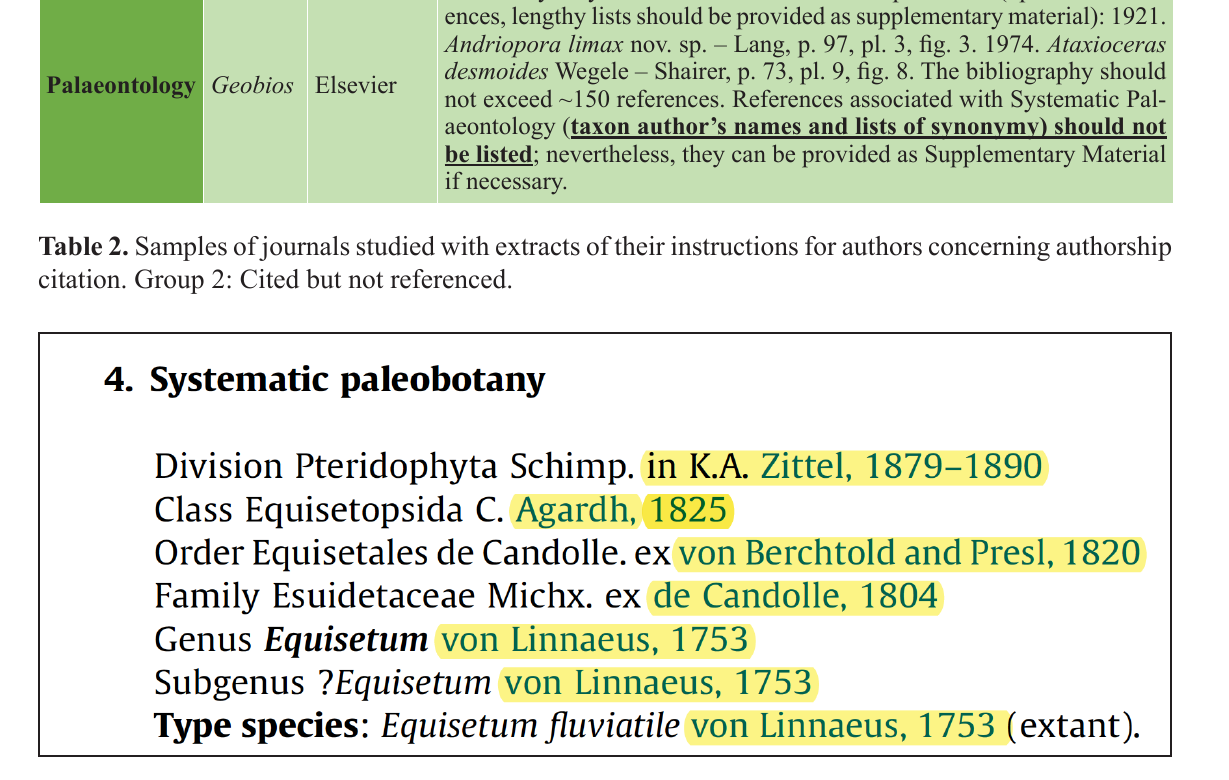
Fig. 8. All authorships cited highlighted in yellow are listed in the references section even though they are not cited as a bibliographic reference anywhere else in the text (Pole &